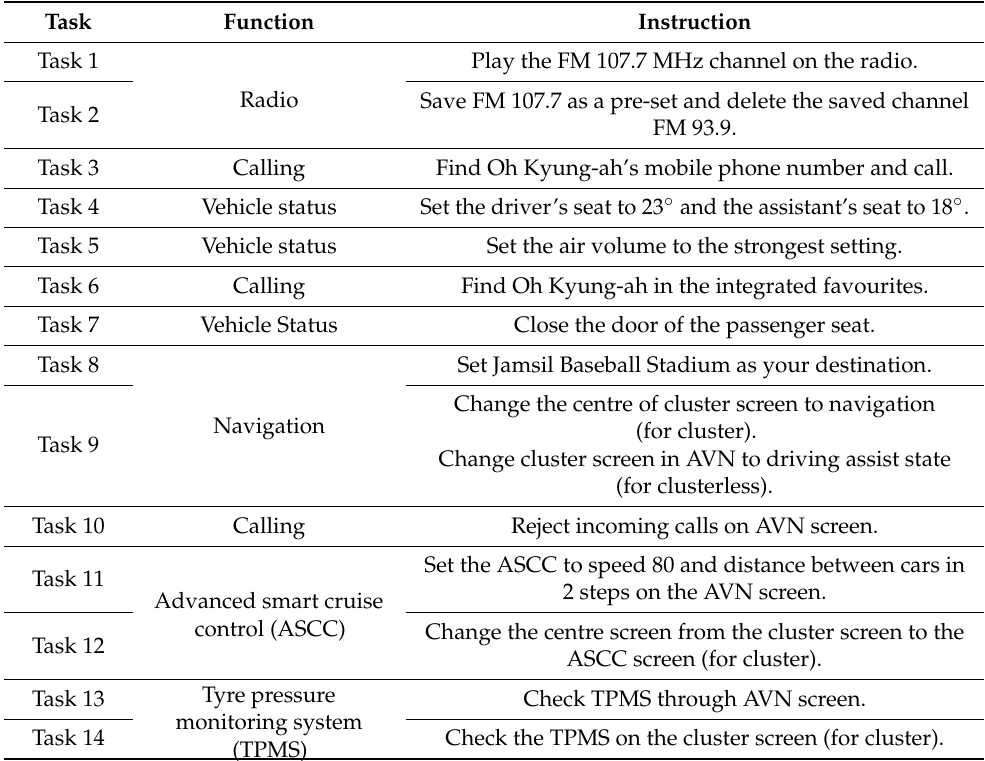
Table 2. Experimental